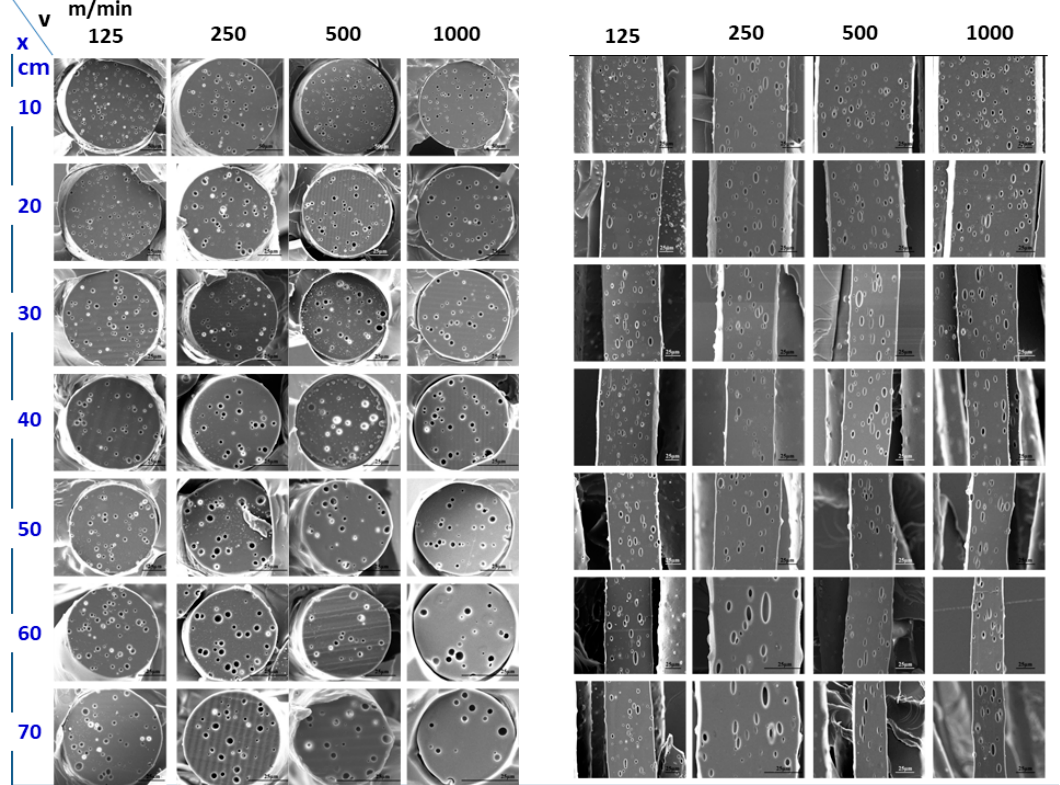
Figure 5. Morphology evolution of PP/PS blend fibers at various take-up velocities (v) along the spinning line (x). The weight percent of the PS phase in the blend fiber is 8%; the zero-shear viscosity ratio of PS/PP is 16.7.